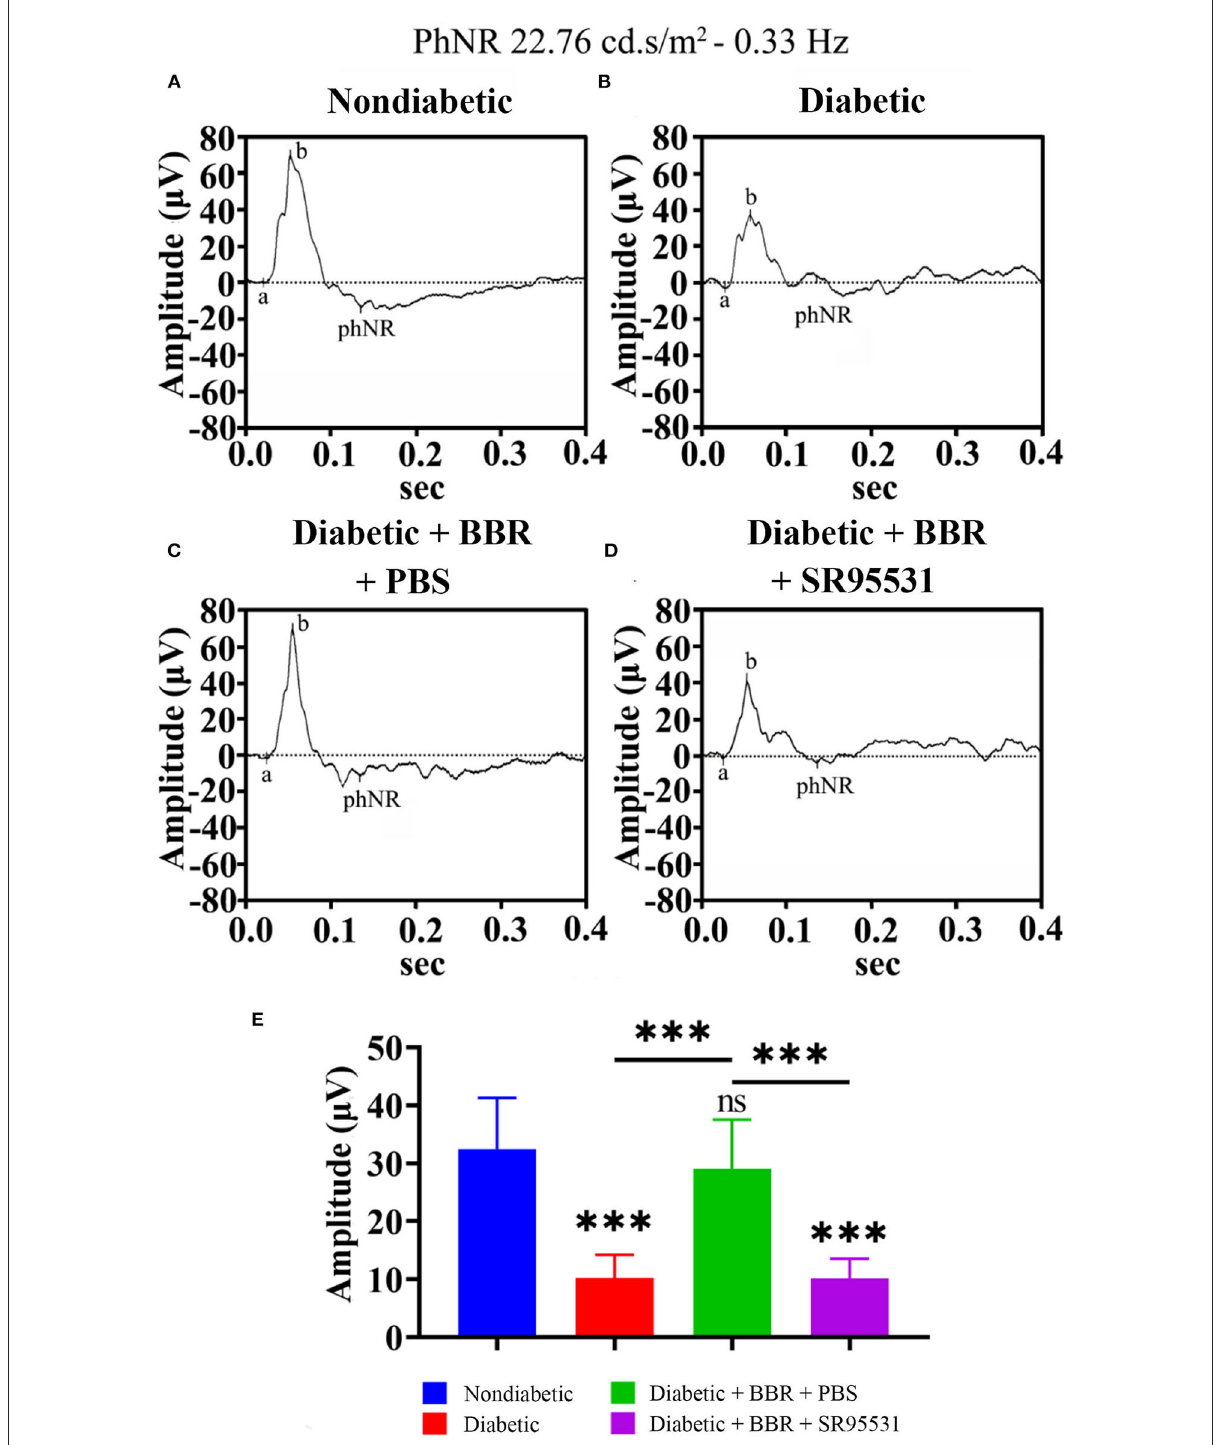
FIGURE6 Effect of BBR on retinal function, as determined by the phNR. (A) Representative traces of the phNR of a control eye of non-diabetic group at step 3 in the presence of a 22.76-cd.s/m 2 , 0.33-Hz stimulus. (B) Representative waves of the eyes of rats in the diabetic group at the same step and in the presence of the same stimulus as in (A) . (C) Representative waves of the eyes of rats in the diabetic + BBR + PBS group at the same step and in the presence of the same stimulus as in (A) . (D) Representative waves of the eyes of rats in the diabetic + BBR + SR95531 group at the same step and in the presence of the same stimulus as in (A) . (E) Quantitative analysis of the phNR amplitude ( n = 8). The amplitude was normalized to the amplitude of the non-diabetic retinas (mean ± SE; ns, no significant difference compared with the non-diabetic group; *** p < 0.001, one-way ANOVA; phNR, photopic negative response; BBR,